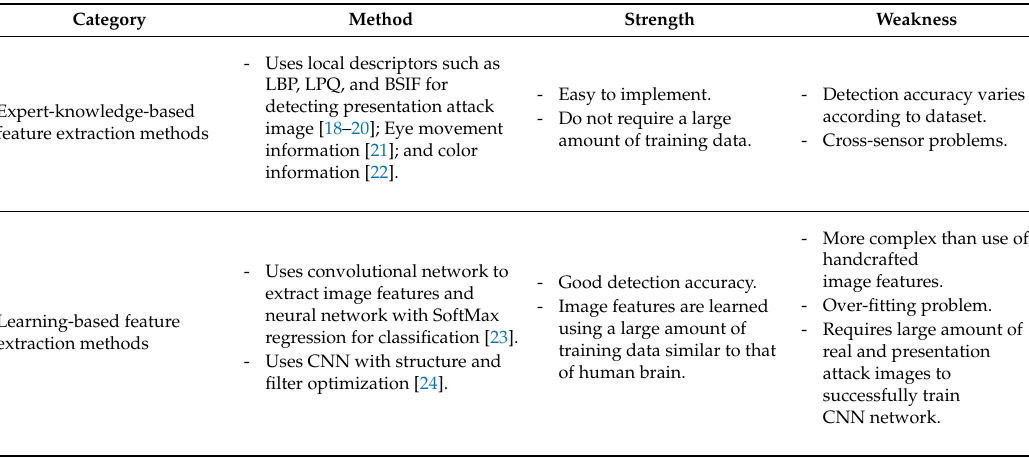
Table 1. Summary of previous studies on iPAD